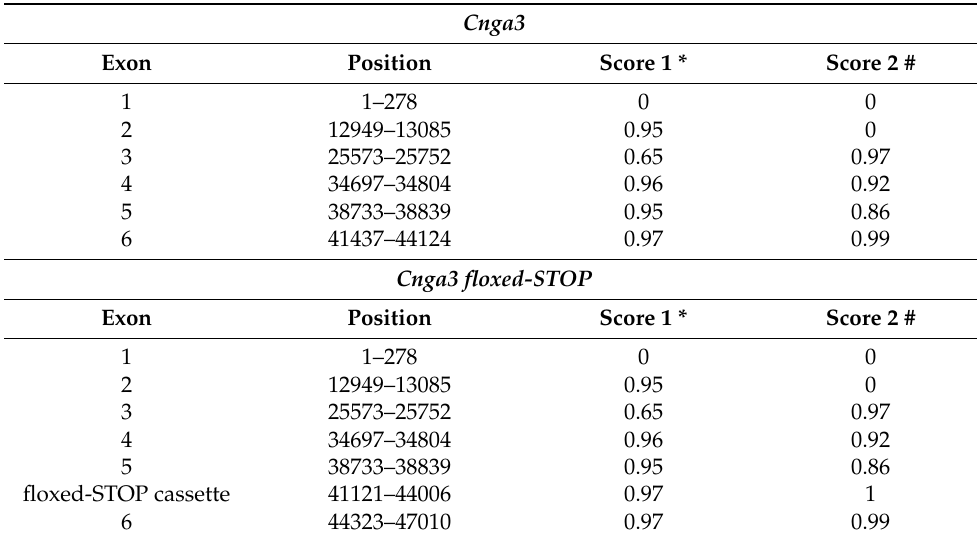
Table 4. Predicted scores of splicing acceptors using two different